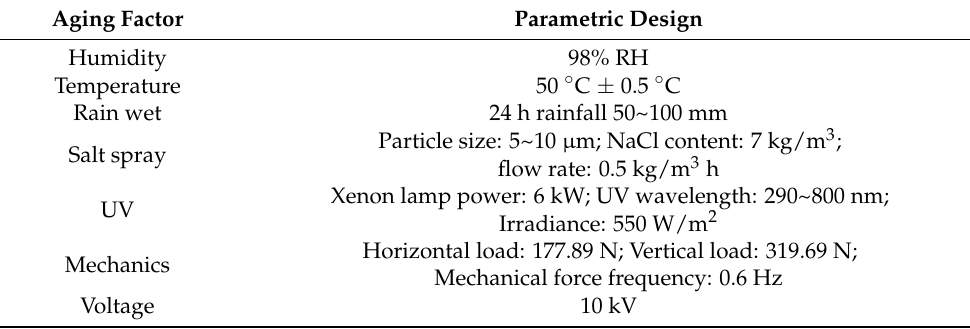
Table 3. Multi-factor Aging Subsystem Design Parameters.